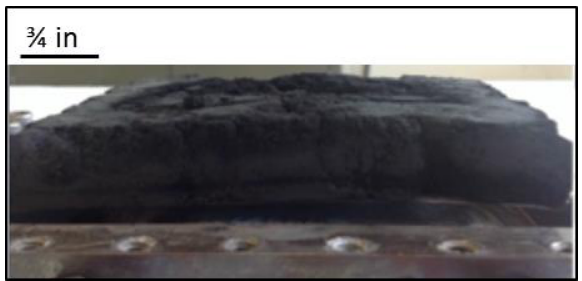
Figure 8. Tridimensional foam generated by the deflector shown in Figure 2f.